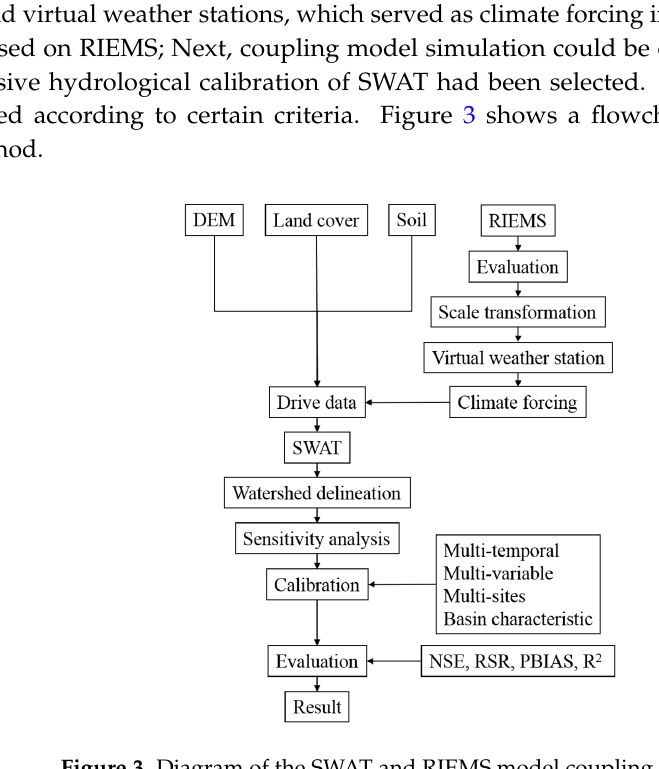
Table 2. Code list of land cover types.